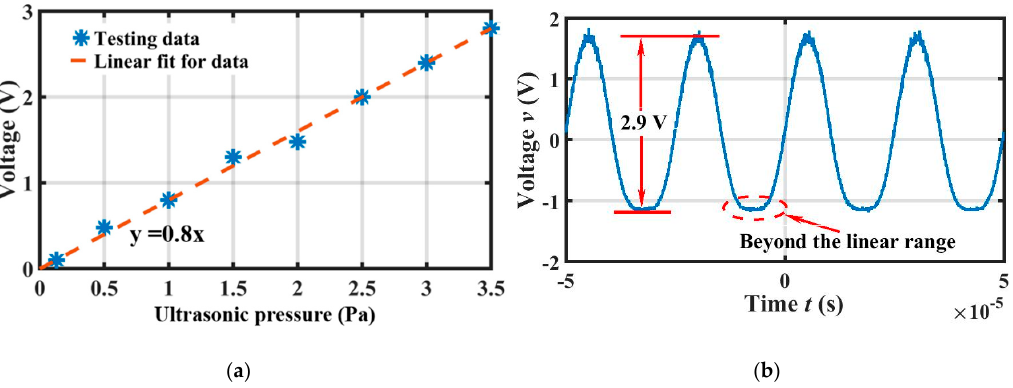
Figure 10. ( a ) Linearity of the sensor from 0.13 Pa to 3.5 Pa; ( b ) Output voltage of the sensor system when the diaphragm deformation exceeded the maximum linear range of FP interference.